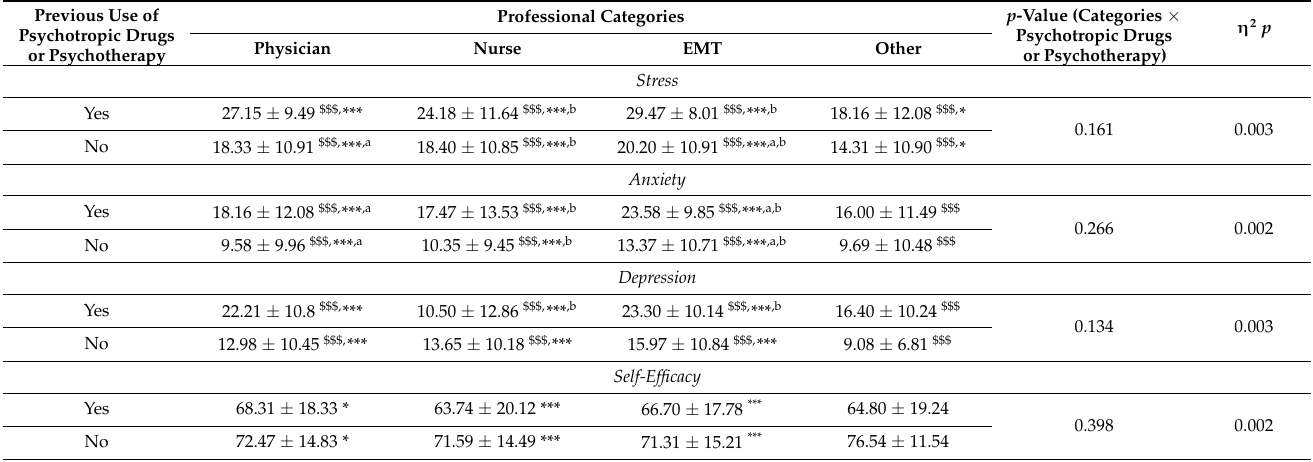
Table 4. Level of stress, anxiety, depression, and self-efficacy according to professional categories and previous use of psychotropic drugs or